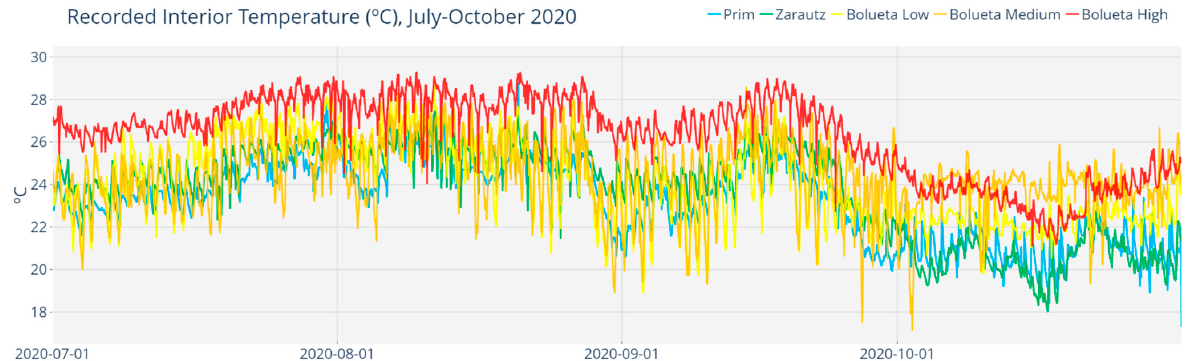
Observing the interior evolution of temperatures in the dwellings, some conclusions can be drawn: Older dwellings have lower interior temperatures. The PH dwellings, in order to maintain lower average temperatures, need to carry out important ventilation actions, as observed in the amplitude between daily maximum and minimum temperatures. The Passivhaus-certified apartments with less action on ventilation suffer from much higher indoor temperatures.